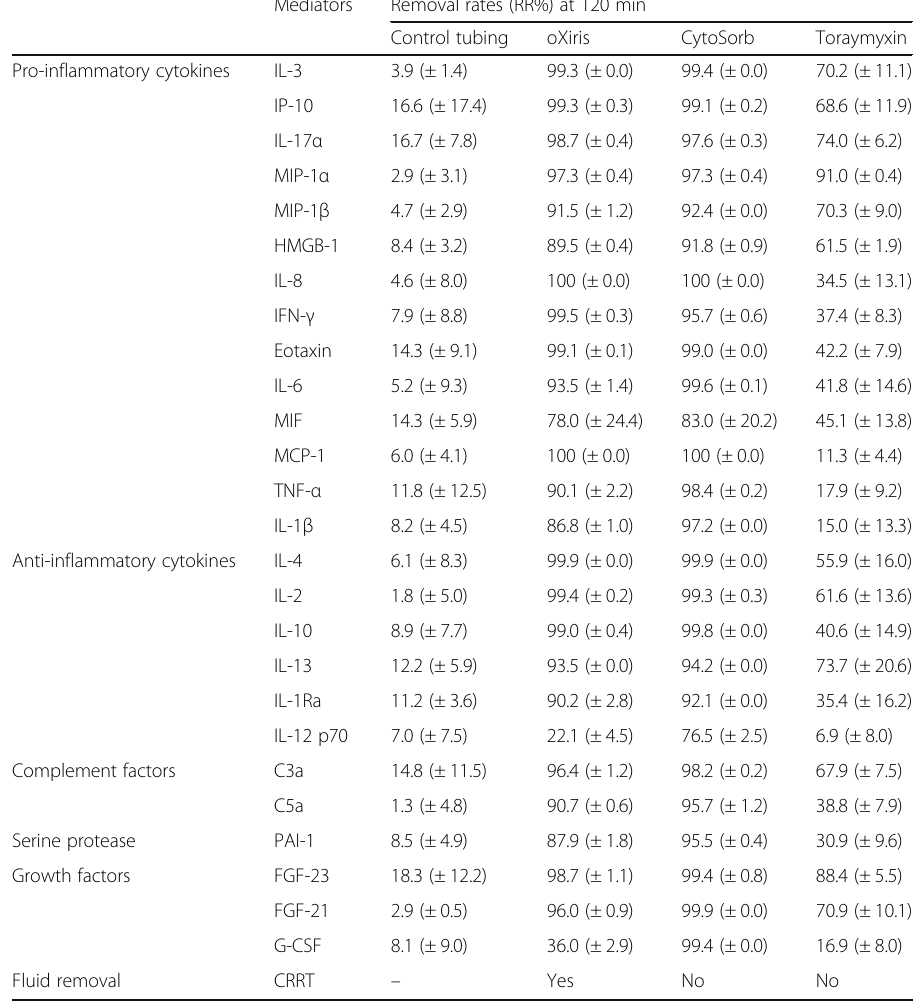
Table 2 Removal capabilities of investigated blood purification device per mediator.